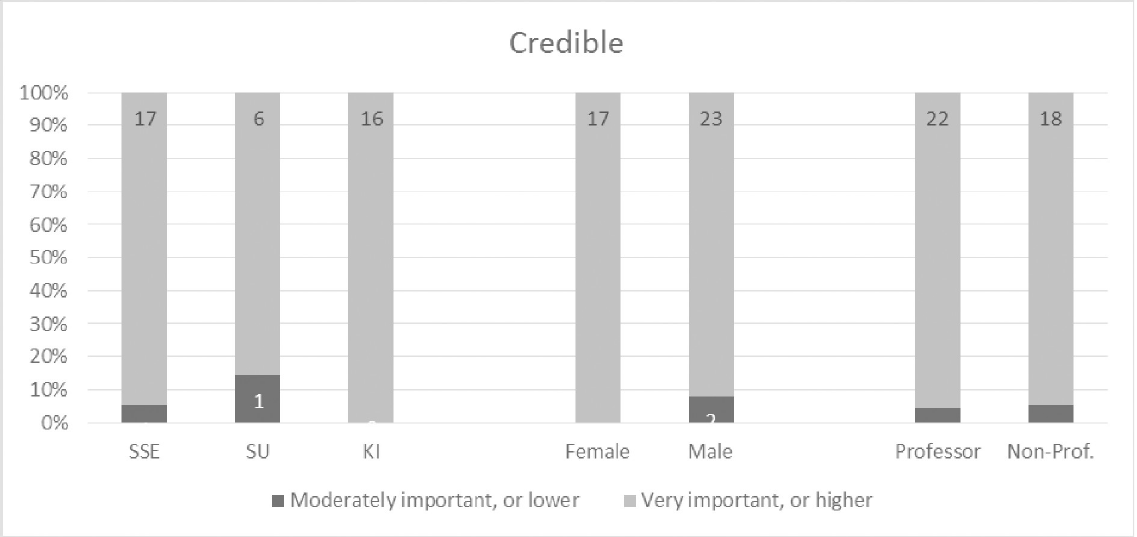
Fig 6. Response rates for credible between universities, gender, and academic level.